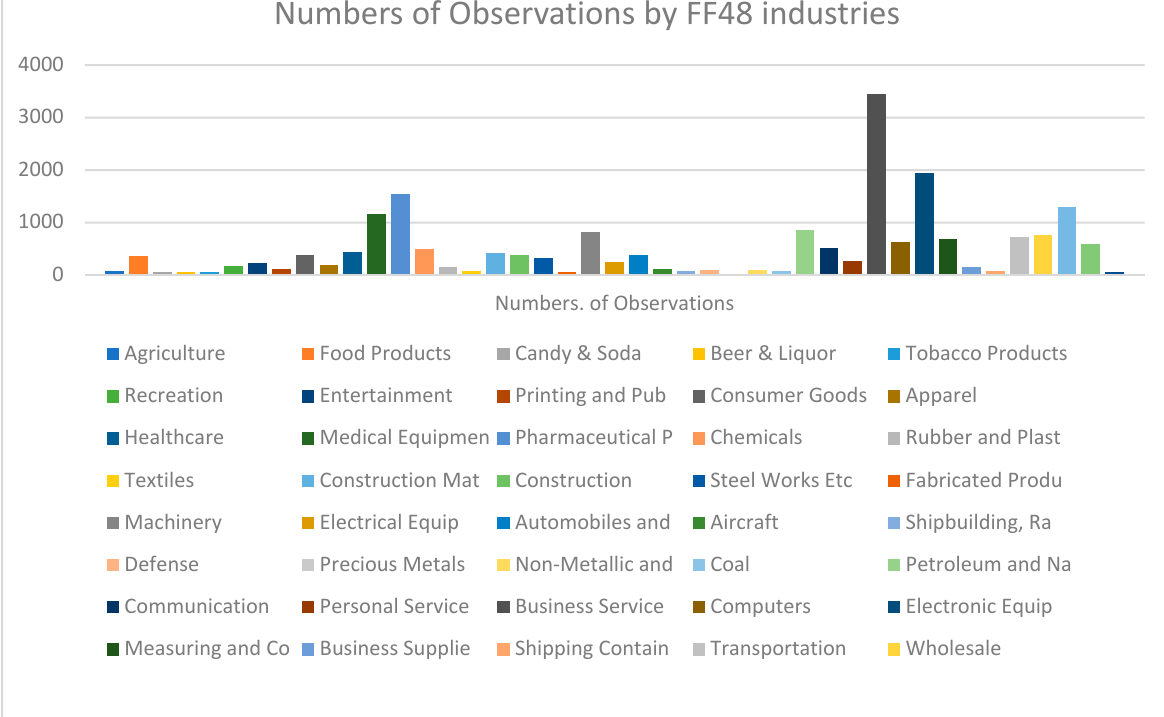
Figure 1. Sample Distribution by industries classified by Fama and French (1997).